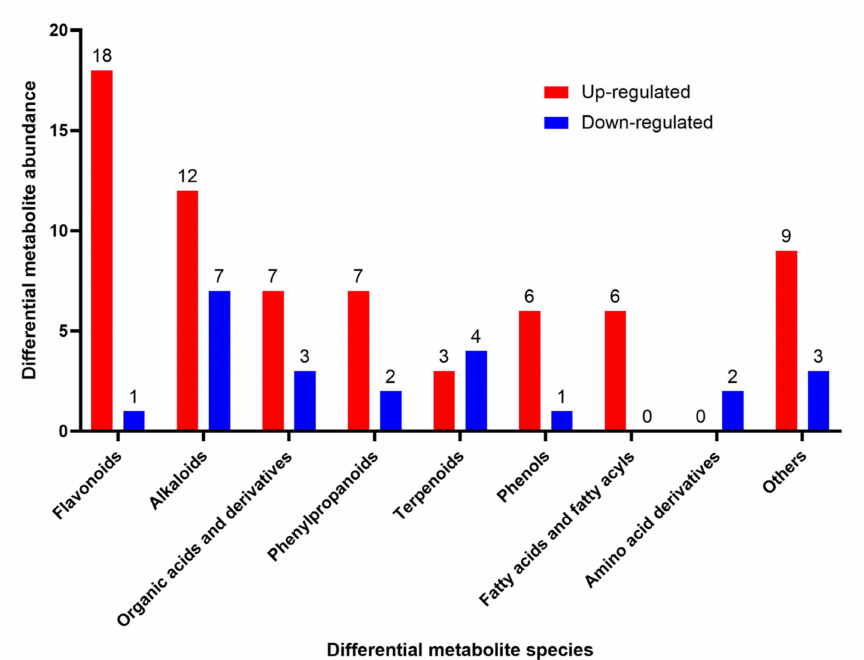
Figure 5. Analysis of differential metabolites in fermented lotus leaves (FLL) compared with those present in pre-fermented lotus leaves (LL). The labels on the bar chart indicate the number of metabolites for each kind of